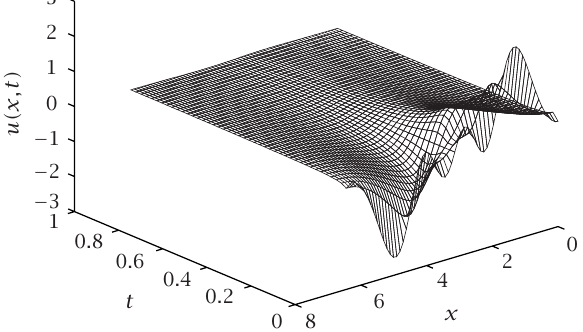
Figure 4.2 . Time evolution of the controlled Burgers equation (3.1) when n = 1, m = 0 . 1, ν = 0 . 3, (a,b,c,d) = ( 1 , 0 , 1 , 0 ) , and r j = 10, j = 1 ,..., 6.